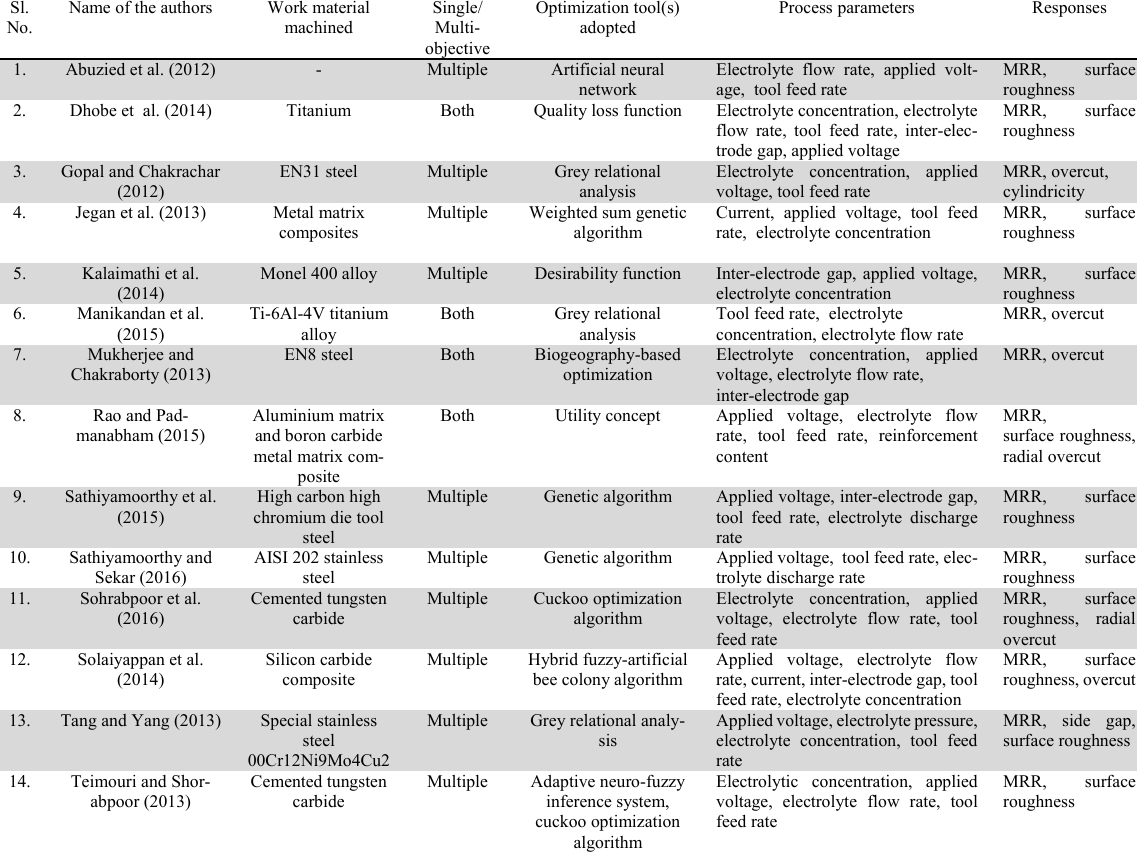
Parameters, responses, work materials and optimization techniques considered in ECM processes Sl. No.